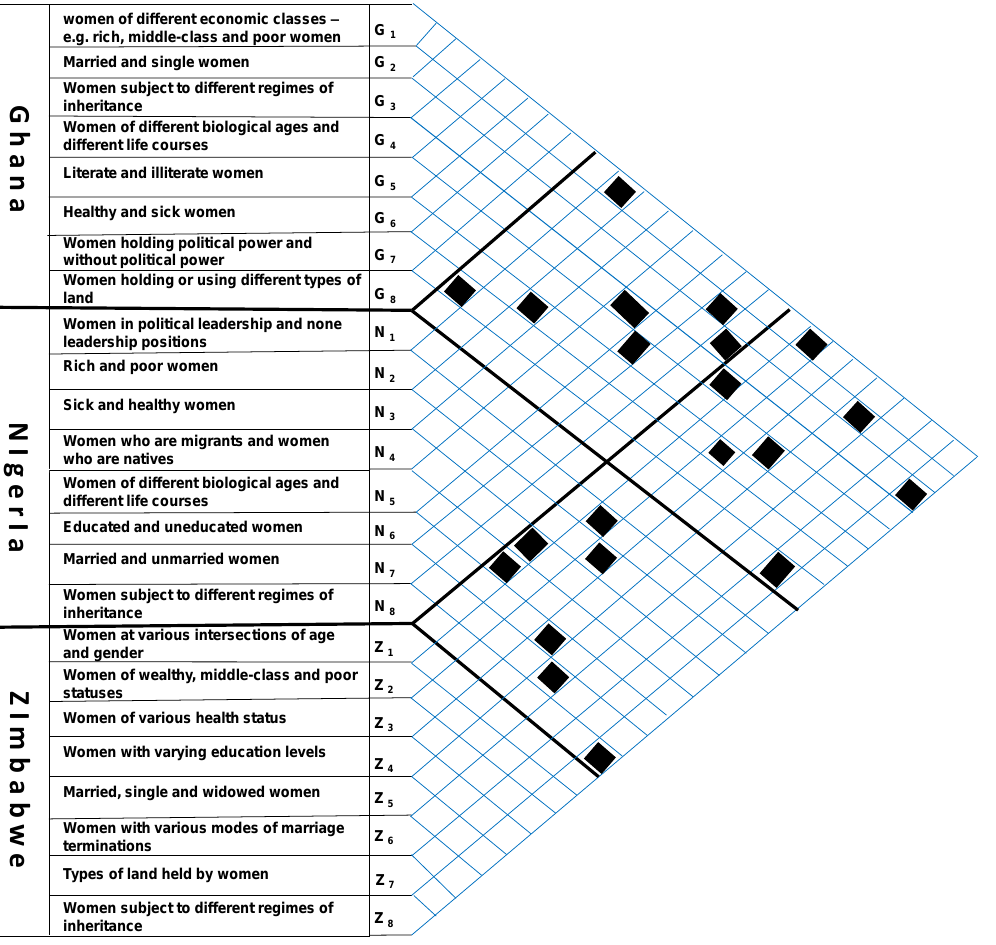
Figure 1. Matrix of situations found to differentiate women’s land access and tenure security